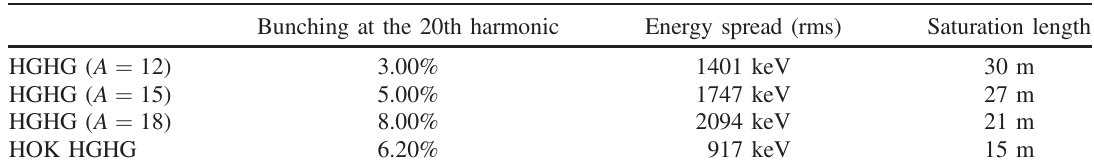
TABLE II. Overview of output radiation simulations. The final FEL radiation is resonant at 2.5 nm, which is the 20th harmonic of the seed laser wavelength in the four cases. For the energy spread and bunching, the values are calculated from the entrance of the radiator.